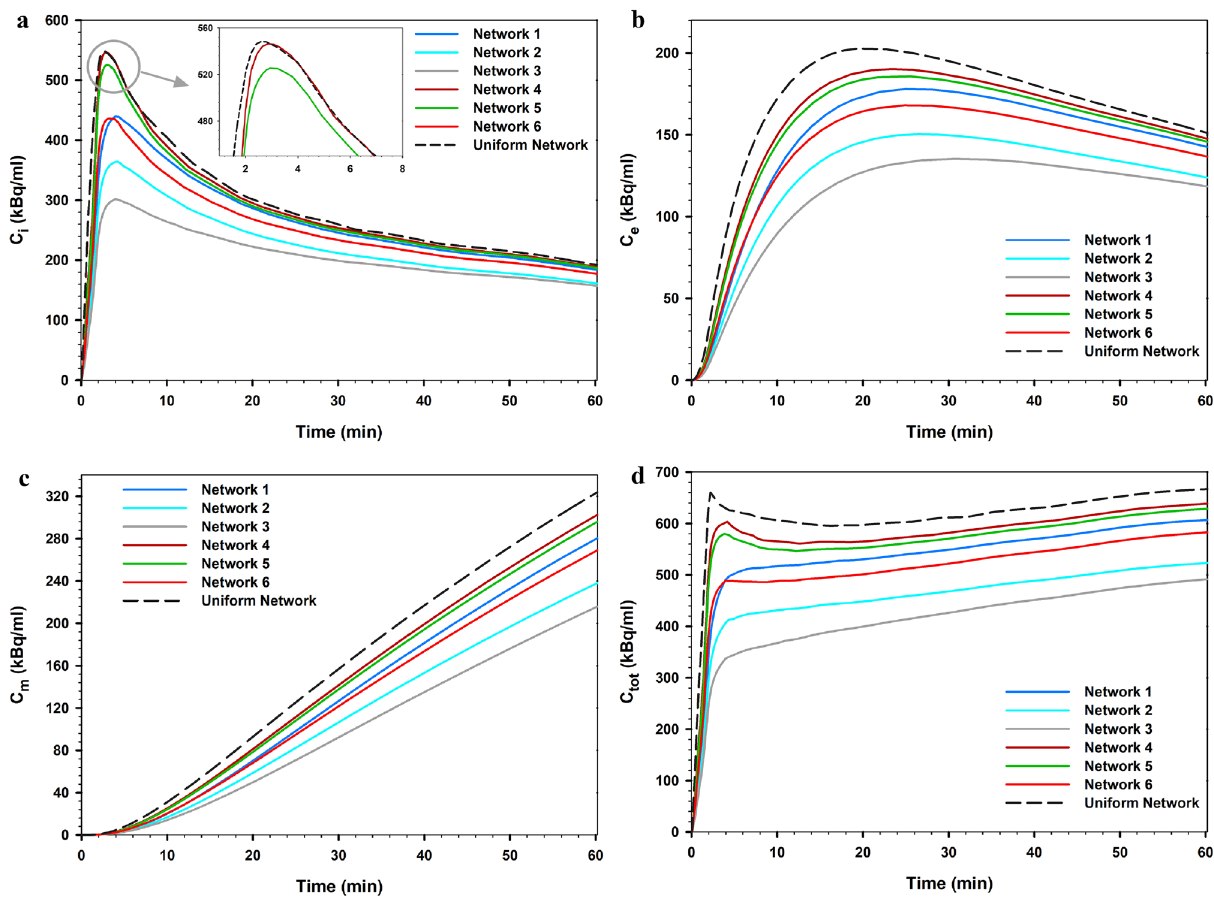
Figure 11. Comparison of the mean FDG concentration in the tumor tissue of all six considered networks calculated via the SDM method and the ‘uniform network’ state. ( a ) C i , ( b ) C e , ( c ) C m , and ( d ) C tot (summation of last 3